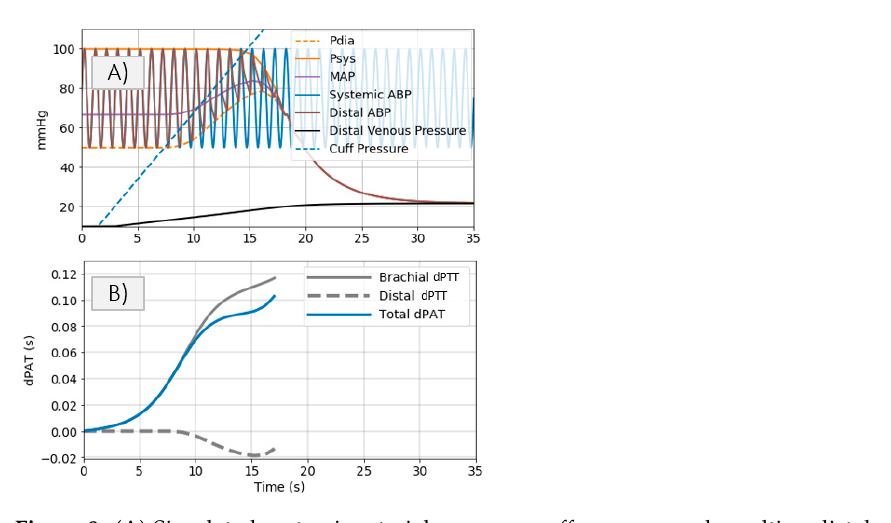
Figure 8. ( A ) Simulated systemic arterial pressure, cuff pressure and resulting distal arterial and venous pressure. ( B ) Simulated total ∆ PAT , ∆ PTT brachial , and ∆ PTT distal .